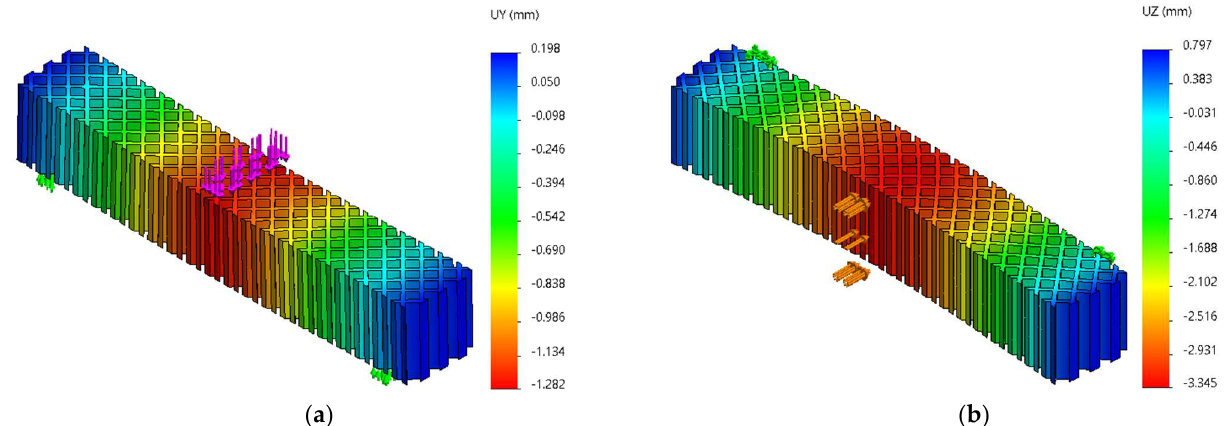
Figure 20. The Uy and Uz displacements charts obtained from FEM analysis of three-point bending of the grid structure: ( a ) Fy = 70 N, ( b ) Fz = 70 N.